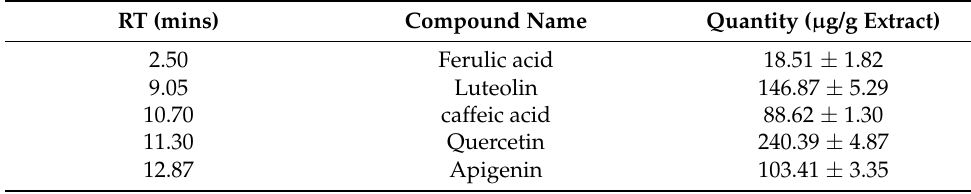
Table 5. The quantification of selected compounds in the extract via HPLC.